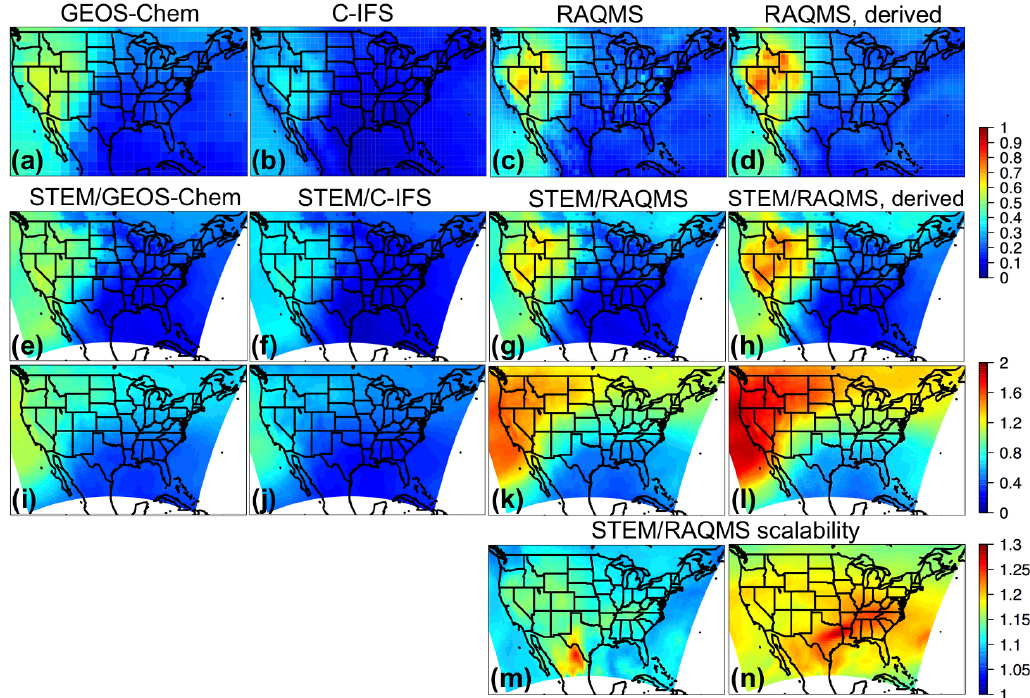
Figure 8. The monthly mean R (O 3 , EAS, 20%) in June 2010 for (a–d) surface O 3 (ppbv) from the three boundary condition models, (e–h) STEM surface O 3 (ppbv), and (i–l) STEM column O 3 ( × 10 16 moleculescm − 2 ). R (O 3 , EAS, 20%) values from the simulations associated with GEOS-Chem, ECMWF C-IFS, and RAQMS are shown in (a, e, i) , (b, f, j) , and (c, g, k) , respectively. Panels (d, h, l) show 1 / 5 of the R (O 3 , EAS, 100%) values from the simulations related to RAQMS. STEM/RAQMS-based “scalability” S O NAM are shown for (m) surface and (n) column O 3 .